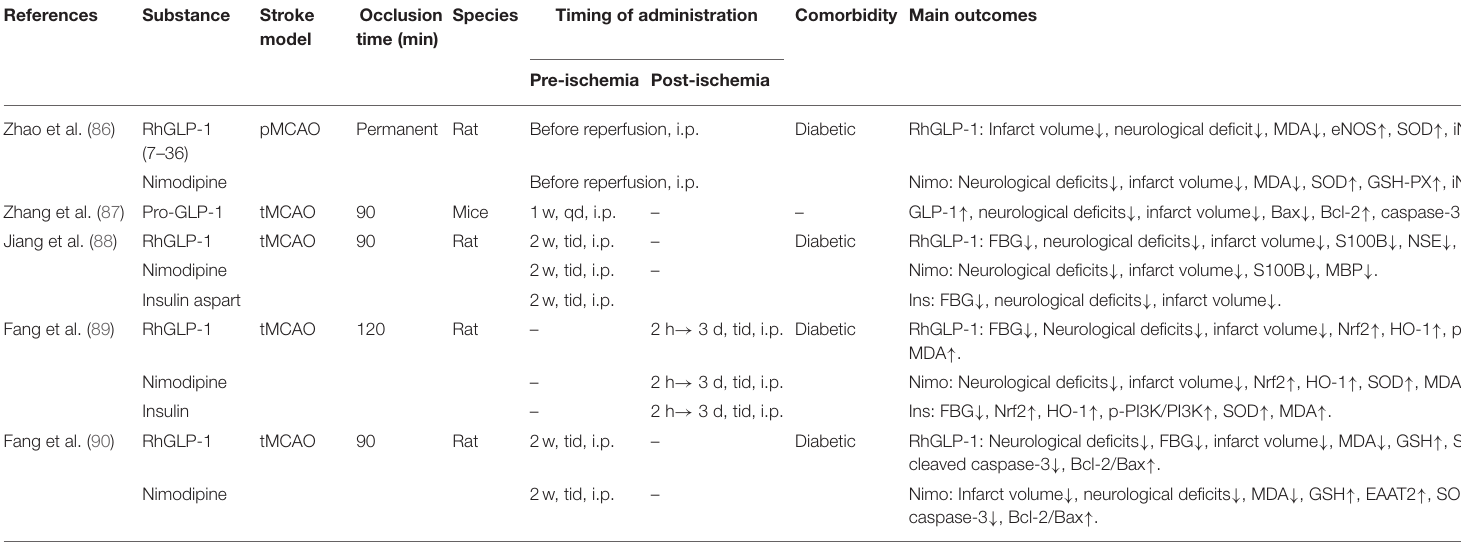
TABLE 2A | A review of preclinical studies of GLP-1 and GLP-1RAs in stroke.